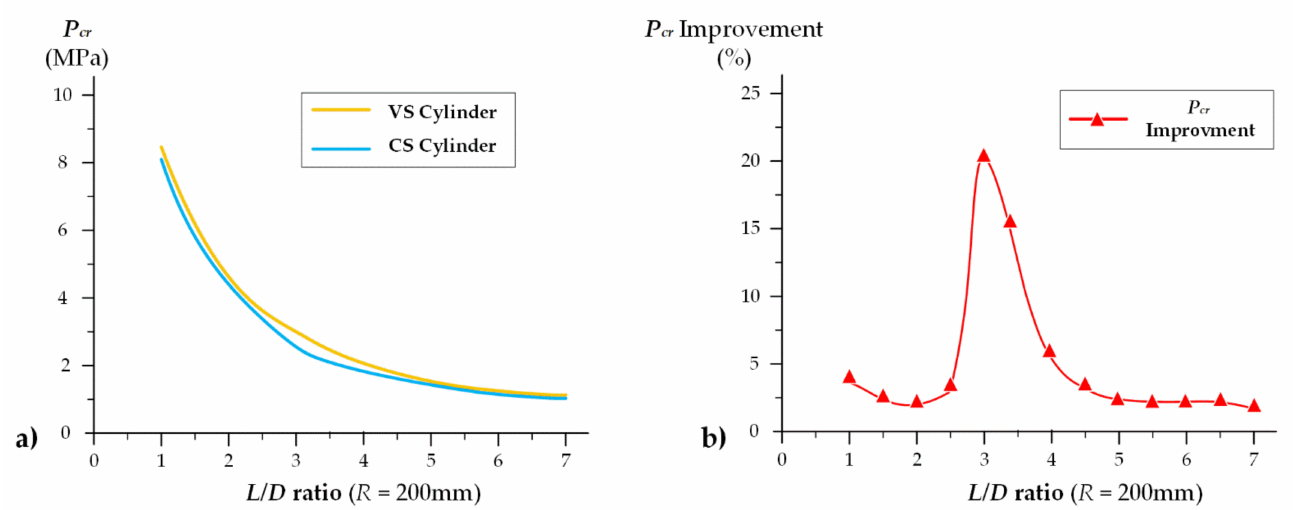
Figure 12. The optimum P cr and P cr improvement for different L / D ratio: ( a ) the optimum P cr of VS and CS cylinders and ( b ) the P cr improvement between VS and CS cylinders.